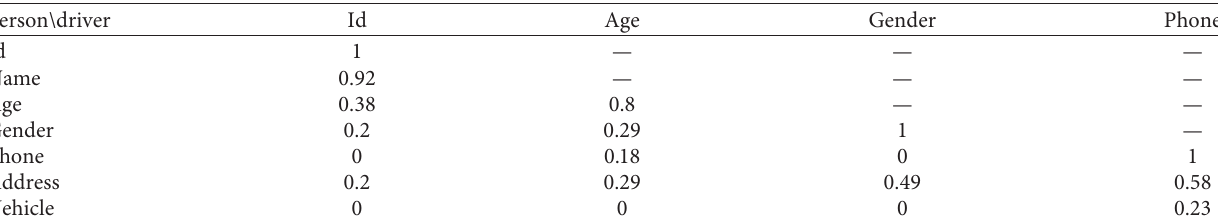
Table 7: Matching between attributes, Set 2.